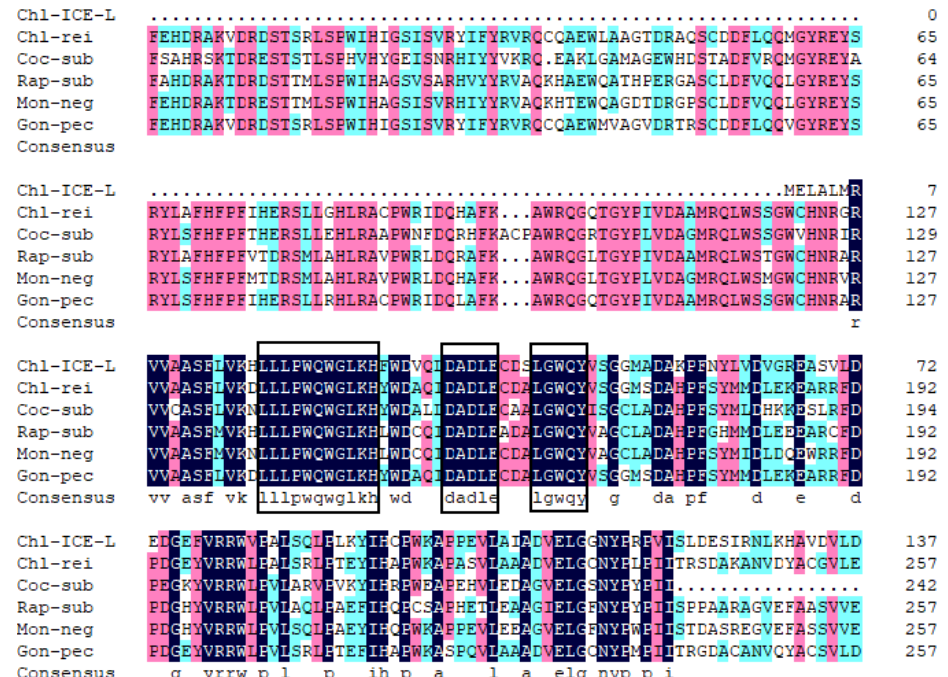
Figure 1. Alignment comparison of the deduced amino acid sequences of CiPlant-CRY1 with other species. Chl-ICE-L: Chlamydomonas sp. ICE-L, Chl-rei: C. reinhardtii , Coc-sub: C. subellipsoidea C-169, Rap-sub: Raphidocelis subcapitata, Mon-neg: Monoraphidium neglectum , Gon-pec: Gonium pectoral . The frame represents the conservative domain of Plant-CRY protein.